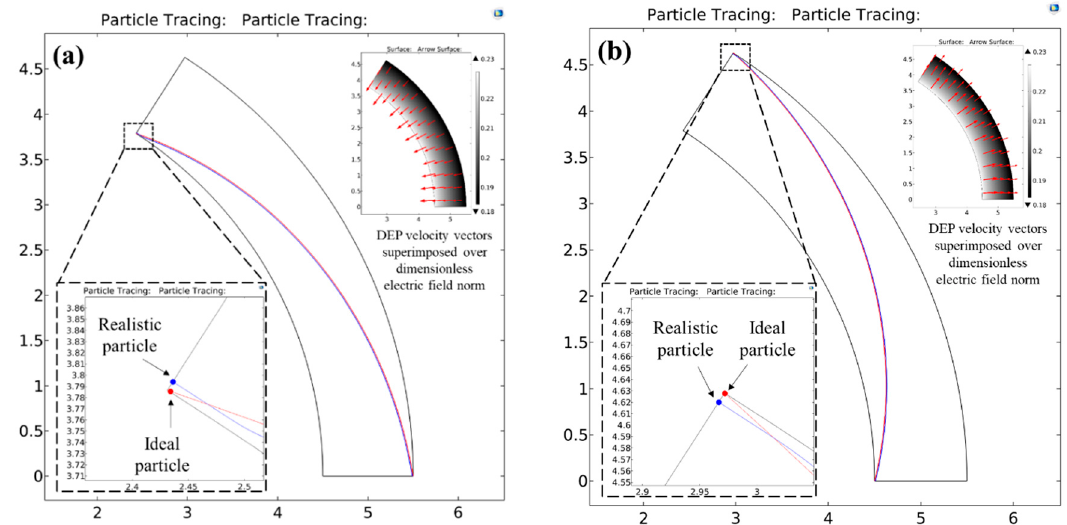
Figure 3. Numerically predicted path-lines for two test particles of a dimensionless diameter d ∗ = 0.005 under the action of ( a ) positive DEP ( Real ( f CM ) = 0.5) and ( b ) negative DEP ( Real ( f CM ) = − 0.5) inside a circular arc microchannel having a curvature ratio R C ∗ of 5. The dimensionless applied voltage (cid:12) V App (cid:12) for both the DEP directions is 400,000, as calculated from the exact solution. The ideal particle is represented by the red colour and its motion is governed by the exact solution. The realistic particle is represented by the blue colour and its motion is governed by the full solution of particle motion inclusive of wall repulsion effects. This particle size demonstrates a regime 1 behaviour, where the design parameters for the C-iDEP microchannel can be determined reliably by the exact solution. The inset images show the DEP velocity vectors superimposed over the electric field norms, confirming an agreement of the simulated particle dynamics with their theoretical predictions.